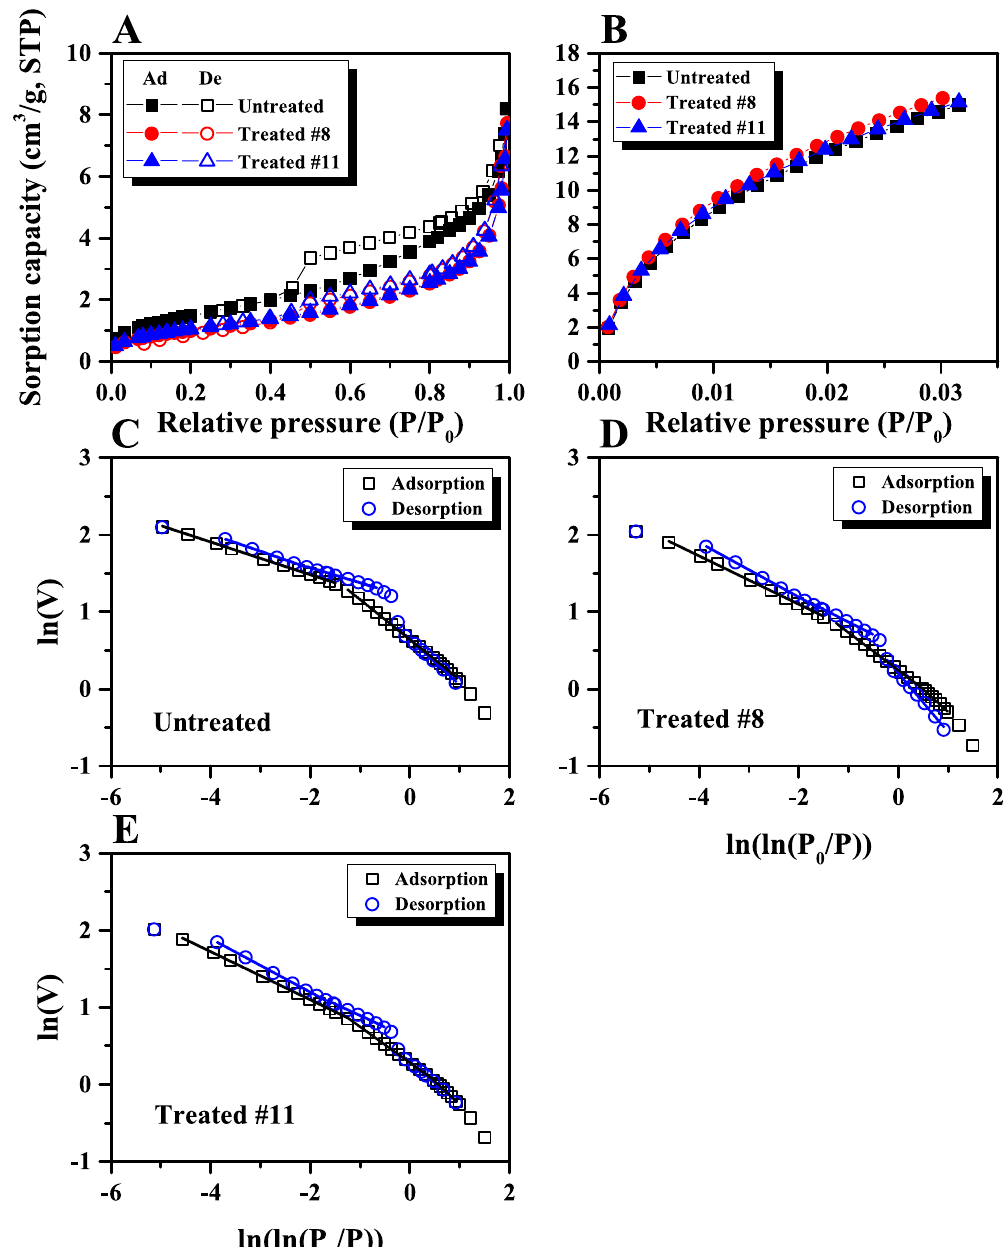
Figure 3. LPGA isotherms for untreated and bioconverted coals. ( A ) N 2 sorption isotherms; ( B ) CO 2 sorption isotherms (Ad: adsorption; De: desorption); FHH fractal analysis from low-pressure N 2 sorption data for untreated and bioconverted coals. ( C ) Untreated coal; ( D ) Treated #8 coal; ( E ) Treated #11